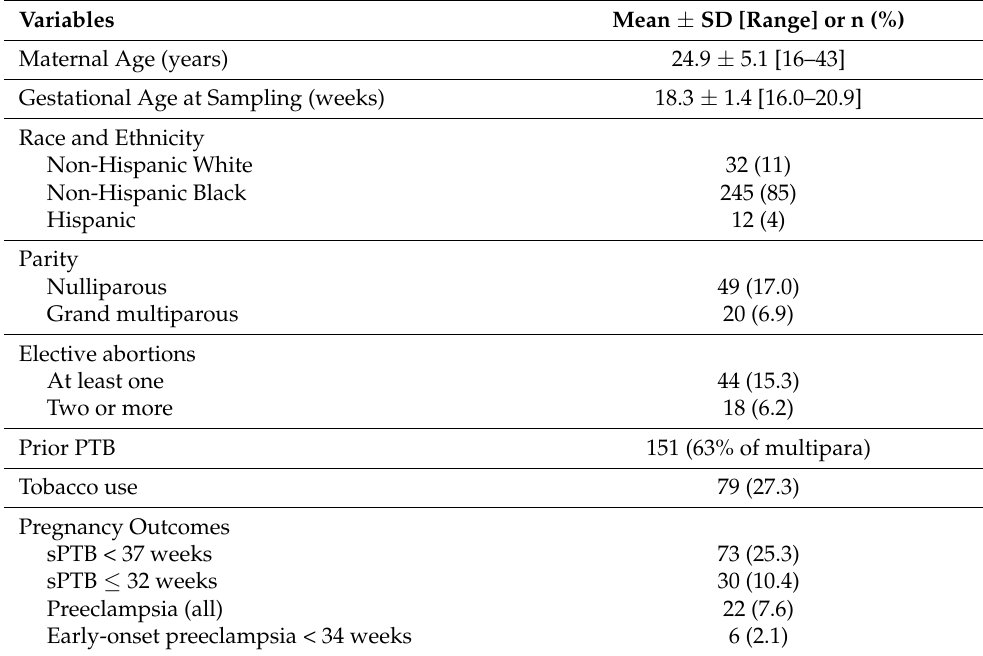
Table 1. Demographic and pregnancy outcomes of the cohort (n =